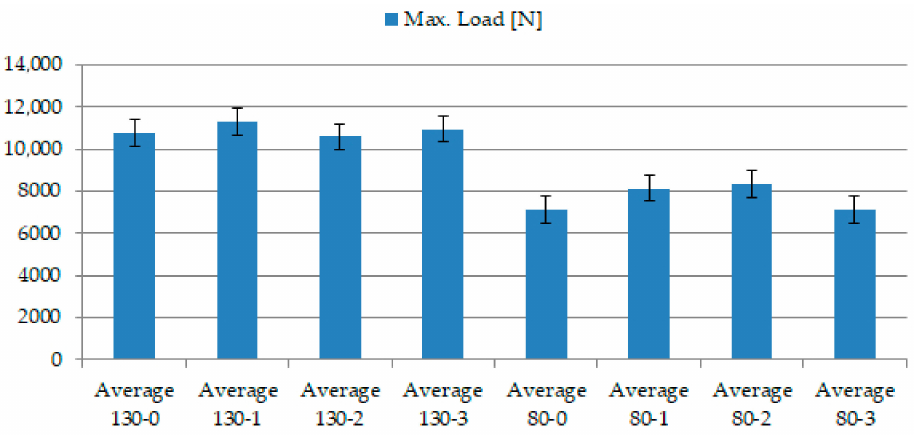
Figure 18. Comparison of average Maximum load [N] values between the type of RFID tag used and the type of fabric